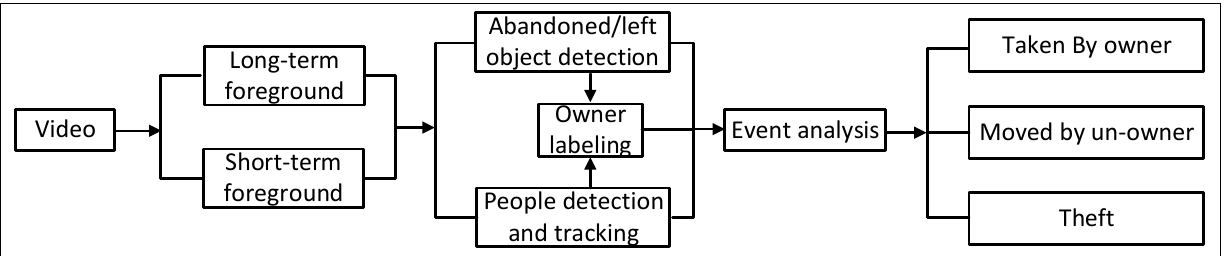
Figure 1: Flowchart of our